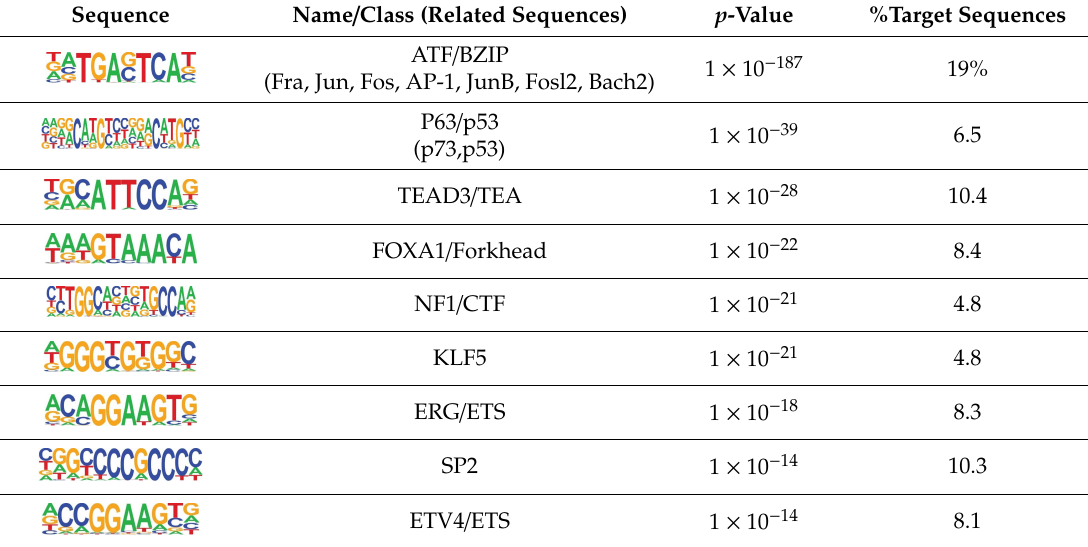
Table 2. Motif analysis of RSV induced nucleosome free